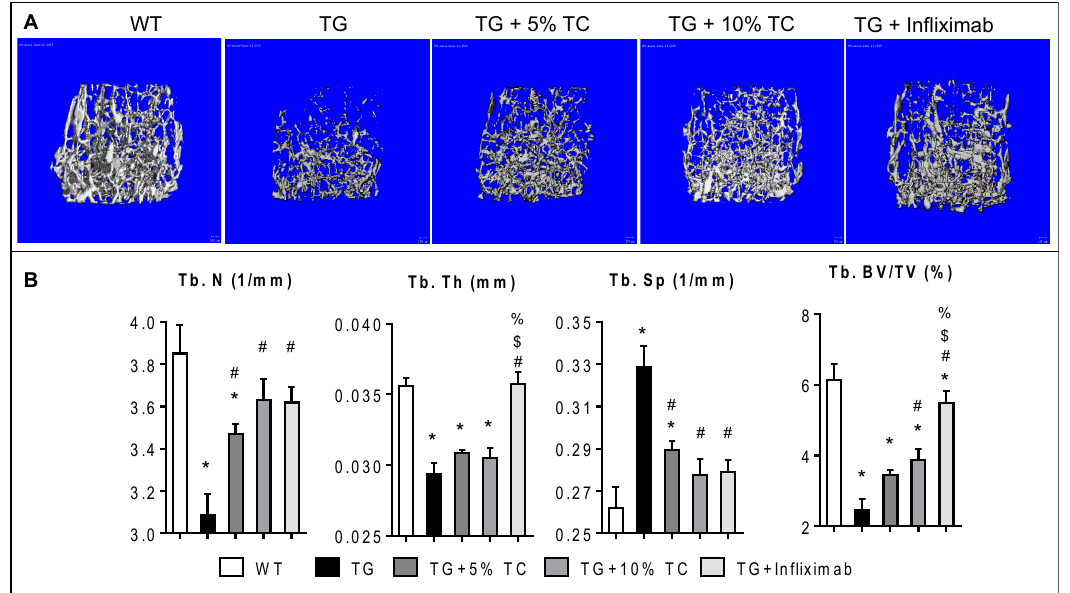
Figure 2. TC diet dose-dependently inhibited TNF-induced decline of trabecular bone mass. ( A ) Microcomputed tomography ( μ CT) scans representing metaphyseal trabecular bone were taken from the femurs of WT, TG, TG + 5% TC, TG + 10% TC, and TG + infliximab mice. ( B ) Trabecular number (Tb.N), thickness (Tb.Th), space (Tb.Sp), and bone mass (Tb.BV/TV) were quantified using µ